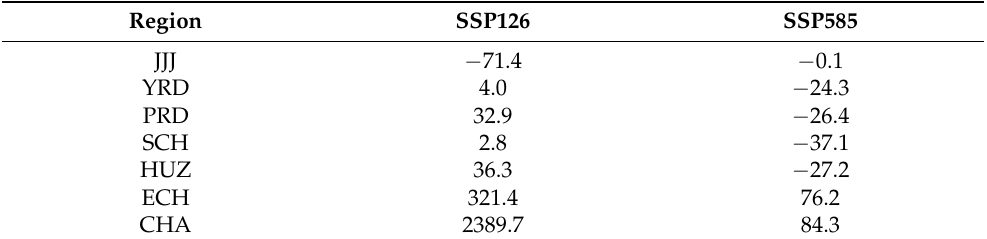
Figure 5. Impact of land-use change on the rate of BVOC emissions under the SSP scenario (unit: moles s − 1 ). Table 3. Impact of land-use change on BVOC emissions in typical regions under the SSP scenarios (unit: GgC).